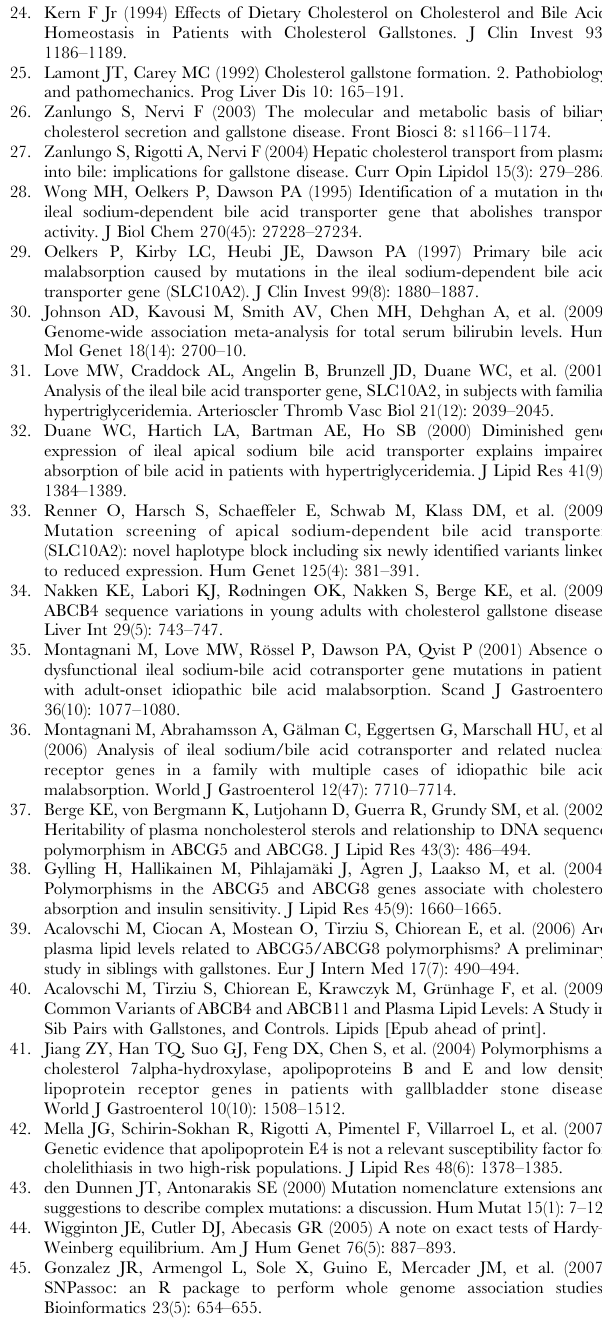
Table S3 Clinical parameters in pooled Stuttgart and Aachen controls and gallstone carriers with distinct rs9514089 genotypes. Values are given as means 6 SEM; BMI= body mass index; a = normal range; b= in the recessive model, corrected by study